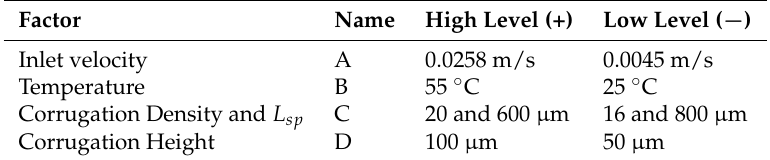
Table 2. Factors and levels used for the 2 4 design for cylindrical and triangular corrugated